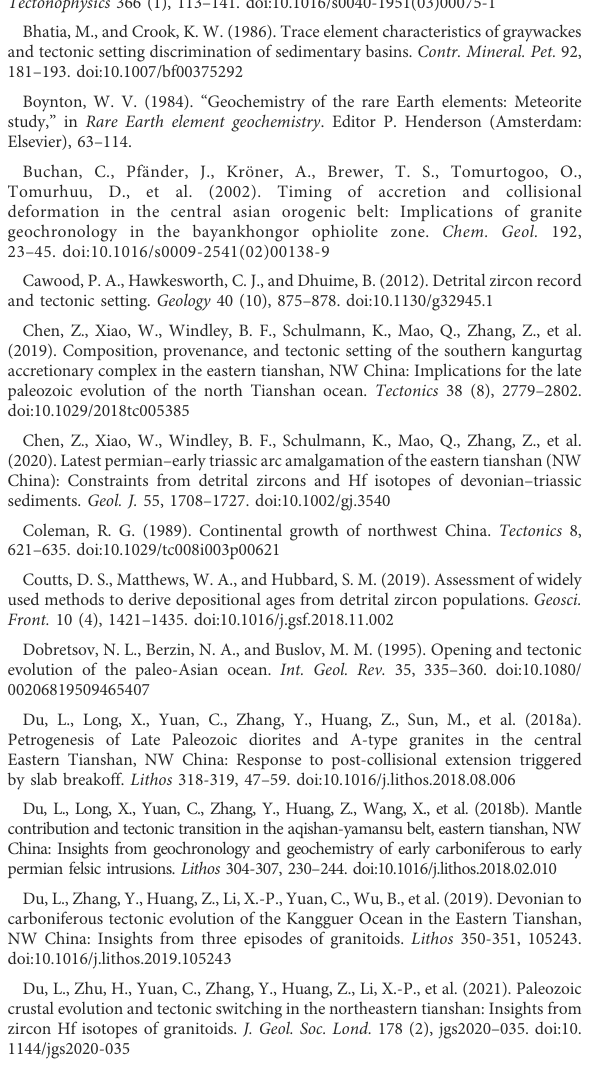
SUPPLEMENTARY TABLE S3 Whole-rock major and trace element data of basalts and sandstone matrix from the KGSC in the Haluo area.